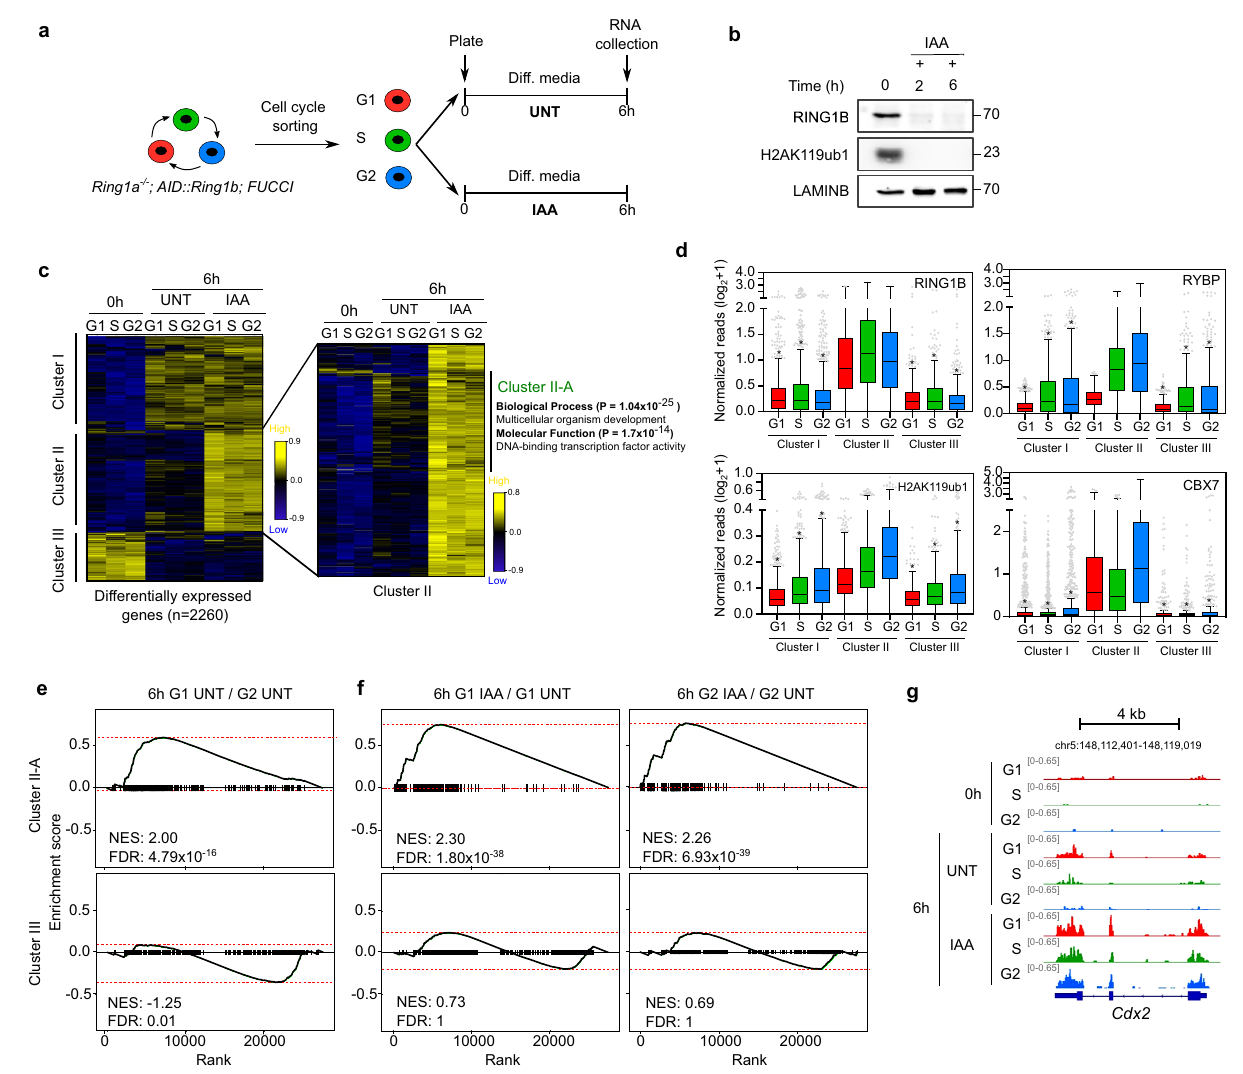
Fig. 6 | RING1B regulates the cell-cycle-dependent induction of gene tran- scription during lineage transition in mESCs. a Scheme representing the experimental strategy to analyze the cell-cycle-phase-speci fi c function of RING1B during lineage. Ring1a − / − ;AID:: Ring1b ;FUCCI mESCs were cell cycle sorted and pla- ted in differentiation media (5 µ M RA in the absence of LIF) with (IAA+) or without (control UNT) auxin (IAA) during 6h before RNA collection. b Western blots of whole cell extracts for RING1B and H2AK119ub1 proteins in Ring1a − / − ;AID:: Ring1b ; - FUCCImESCstreatedwithIAAfortheindicatedtimes.LAMINBwasusedasloading control.MolecularweightisindicatedinkDa.Twobiologicalreplicateswerecarried out. c Hierarchical clustering analysis of RNA expression levels (TMM) of the summation of differentially expressed (2260 genes, FC>2, FDR<0.05) genes (0h vs6hUNTand0hvs6hIAA)atanycellcyclephaseduringRAinduction.ClusterI highlight 871 genes responding to RA stimulation but not to RING1B depletion. Cluster II includes 915 genes that are de-repressed upon RING1B depletion. These